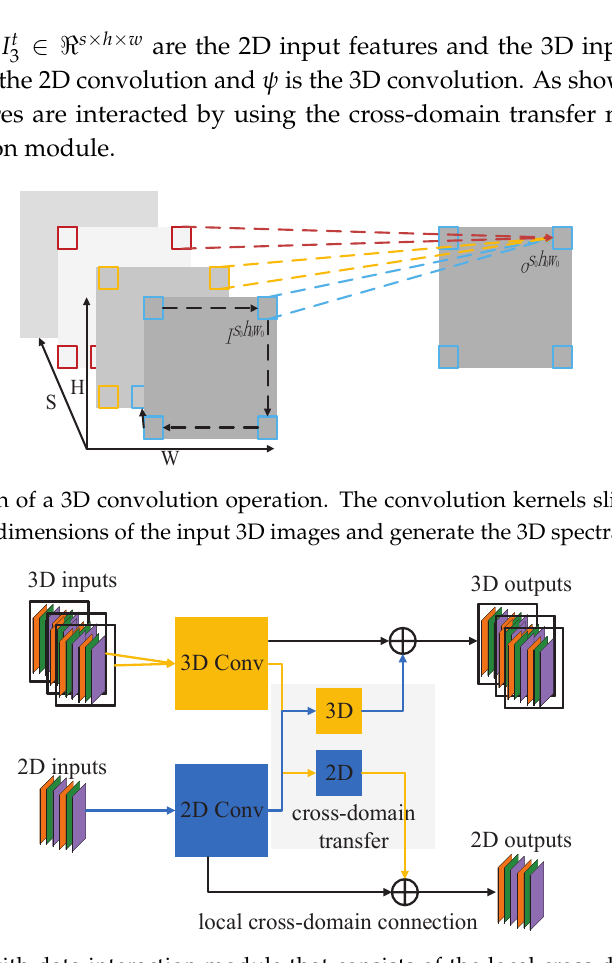
Figure 3. SyCNN with data interaction module that consists of the local cross-domain connection and cross-domain transfer. 2D spectral–spatial fusion is achieved by transferring the 3D inputs to 2D outputs and concatenating these outputs with the 2D inputs. On the other hand, the 3D spectral–spatial fusion is obtained by transferring the 2D inputs to 3D outputs and concatenating these 3D outputs with the 3D